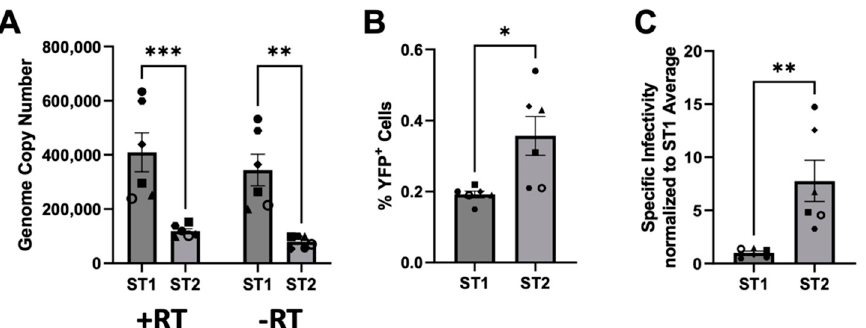
Figure 6. ST2 particles exhibit higher infectivity. ( A ) Viral genome copy number values of DNAse- treated supernatant of ST1 or ST2 producing 293T cells. Nucleic acid was extracted and analyzed by qPCR targeting the pol gene with or without prior reverse transcription (RT). Six biological replicates (rep) were performed. p ≤ 0.01, **; p ≤ 0.001, ***; 2-way ANOVA, Sidak’s correction for multiple comparisons. ( B ) The exact same supernatants as in ( A ) were used to infect fresh 293T indicator cells by spinfection. p ≤ 0.05, *; unpaired t -test. ( C ) Specific infectivity was calculated as the ratio of YFP-expressing cells over DNA genome copy number (-RT) for each sample and was normalized to the average ST1 infectivity. p ≤ 0.01, **; unpaired t -test. Error bars represent the standard error of the mean.